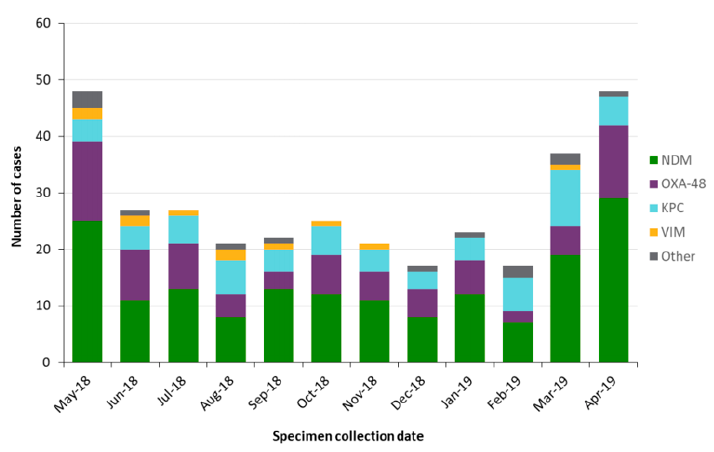
Figure 3. CPE cases by carbapenemase in Ontario, 1 May 2018 to 30 April 2019 ( n = 333). 1.4. Risk Factors for CPE and Implications for Neonates Admitted to the Intensive Care Unit Public Health Ontario identified health care and travel outside of Canada and a med- ical or surgical procedure in Canada in the last 12 months as risk factors for CPE spread. These are significant risk factors given the demographics of Ontario (Table 1) [14]. This suggests that obstetric cases with medical procedures such as in vitro fertilization (IVF) or IVF patients who received healthcare outside of Canada would likely warrant an assess- ment for the risk of CPE colonization. Table 1. Risk factors for CPE cases in Ontario, May 2018 to April 2019 ( n = 289). Clinical aspects related to maternal and newborn care. Risk Factors